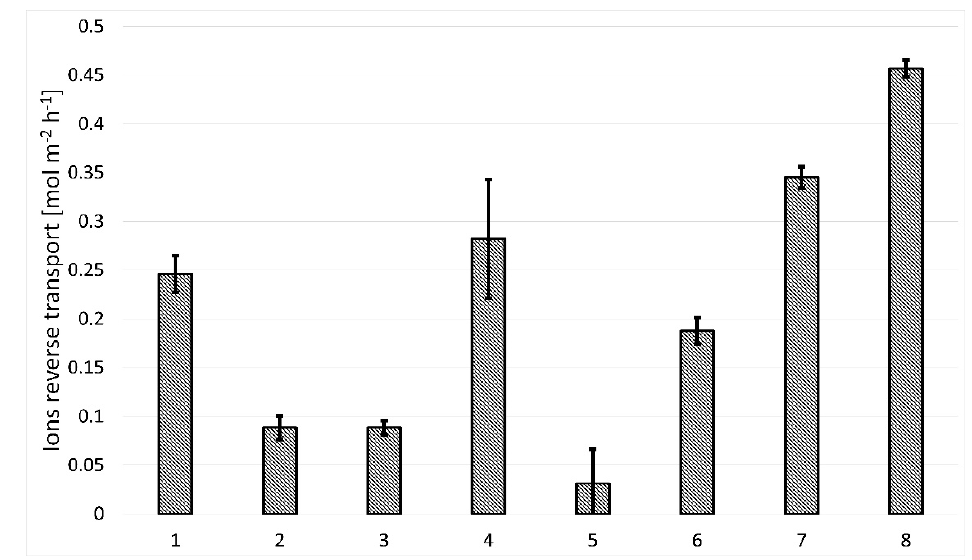
Figure 6. Ion reverse transport through the